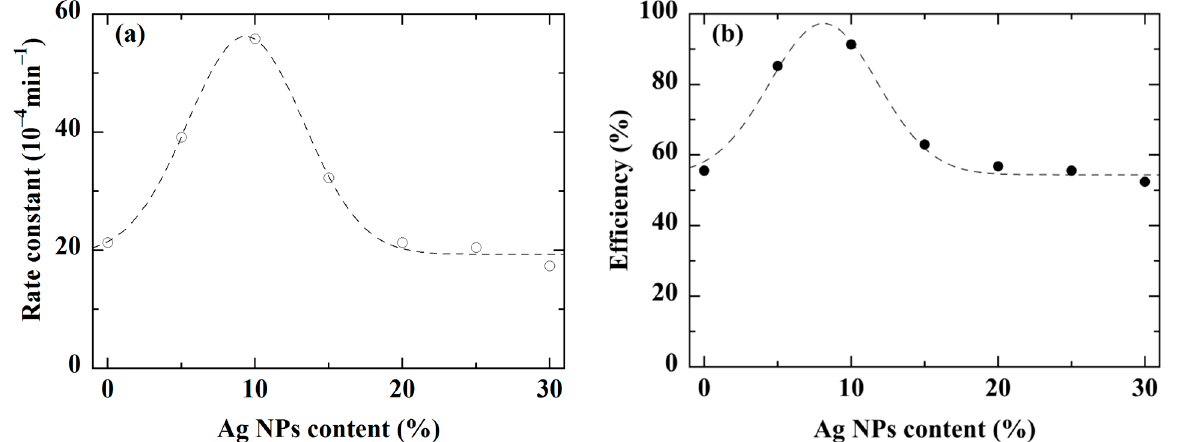
Figure 12. Rate constant ( a ) and photodegradation efficiency ( b ) of an IC solution after 6 h of illumination under UV irradiation, with a ZnO thin film and a ZnO/Ag(NPs) thin film loaded at different Ag(NPs) contents. The curves are provided as guides for the eye.